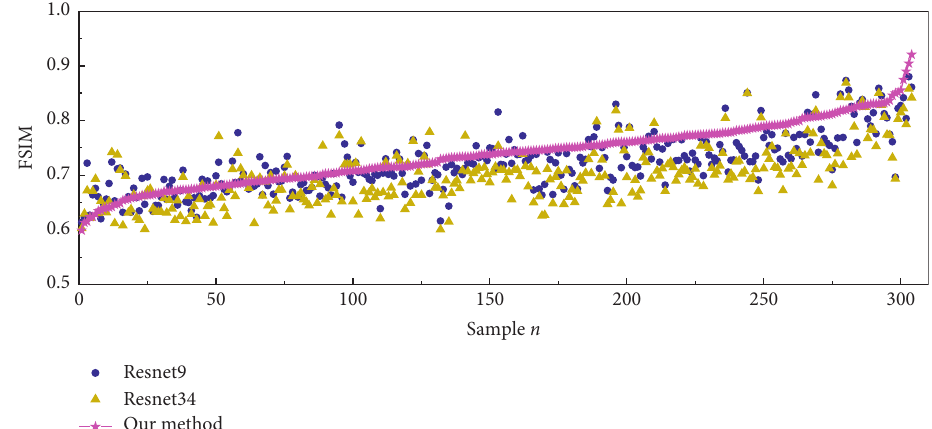
Figure 11: The FSIM results between the real infrared images and the infrared images generated by our method and the Resnet9 and Resnst34. The X -axis represents different test samples and the Y -axis represents the FSIM value corresponding to the